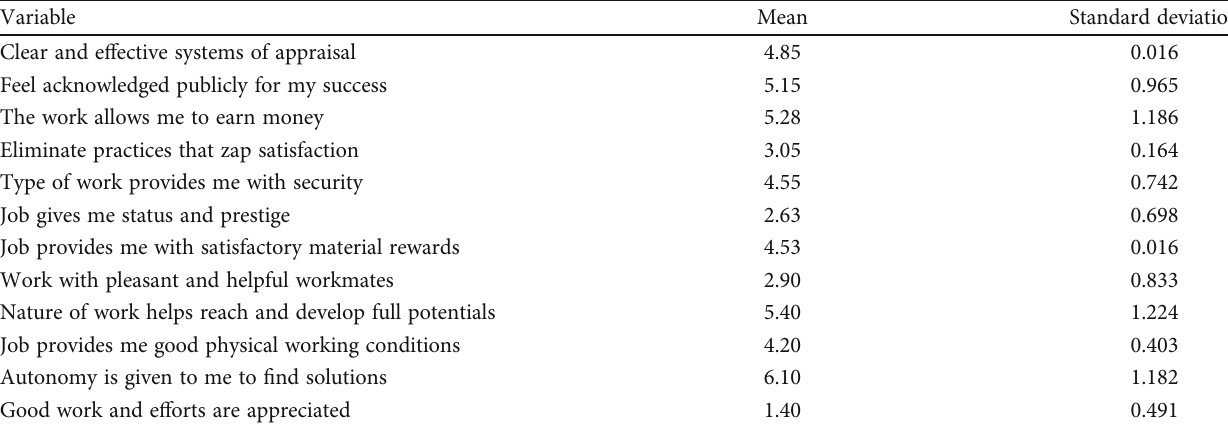
Table 3: Communication methods and internal information sharing